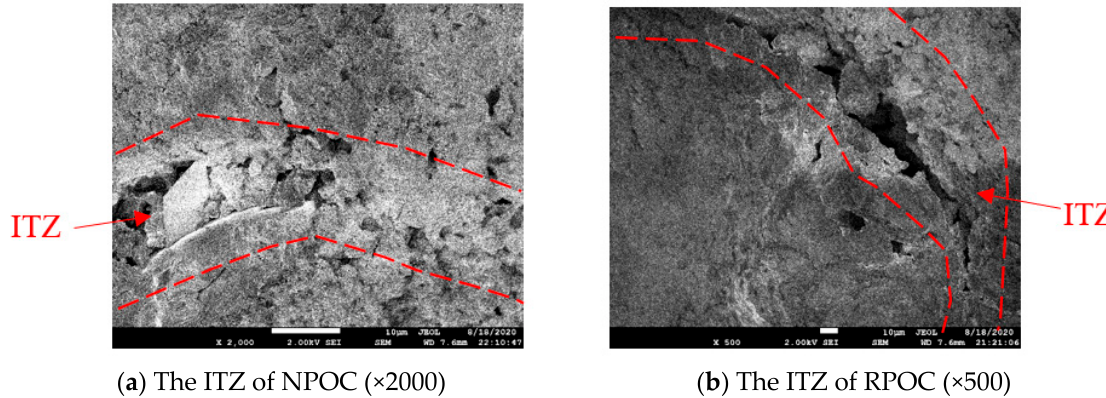
Figure 8. SEM images of ITZ between aggregate and cement paste in different types of porous concrete.